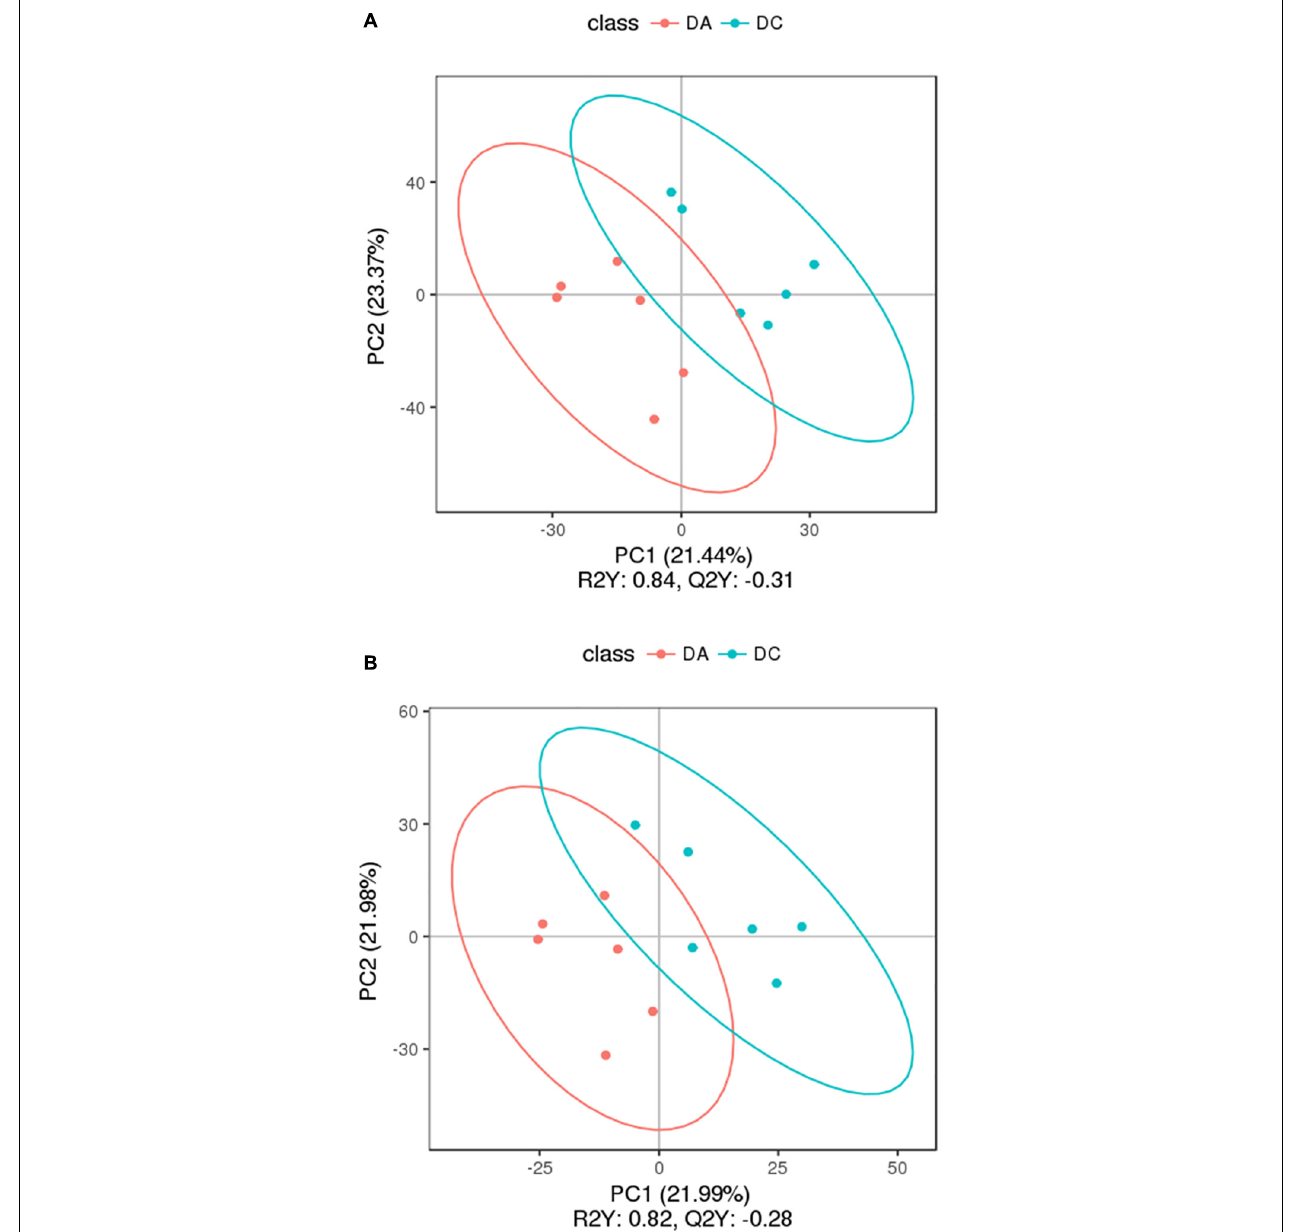
FIGURE 7 | The partial least square-discriminant analysis (PLS-DA) chart. (A) Positive ion mode and (B) negative ion mode.